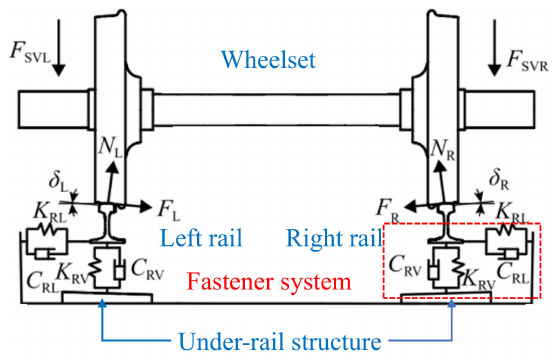
Figure 2. Wheel–rail contact model in straight